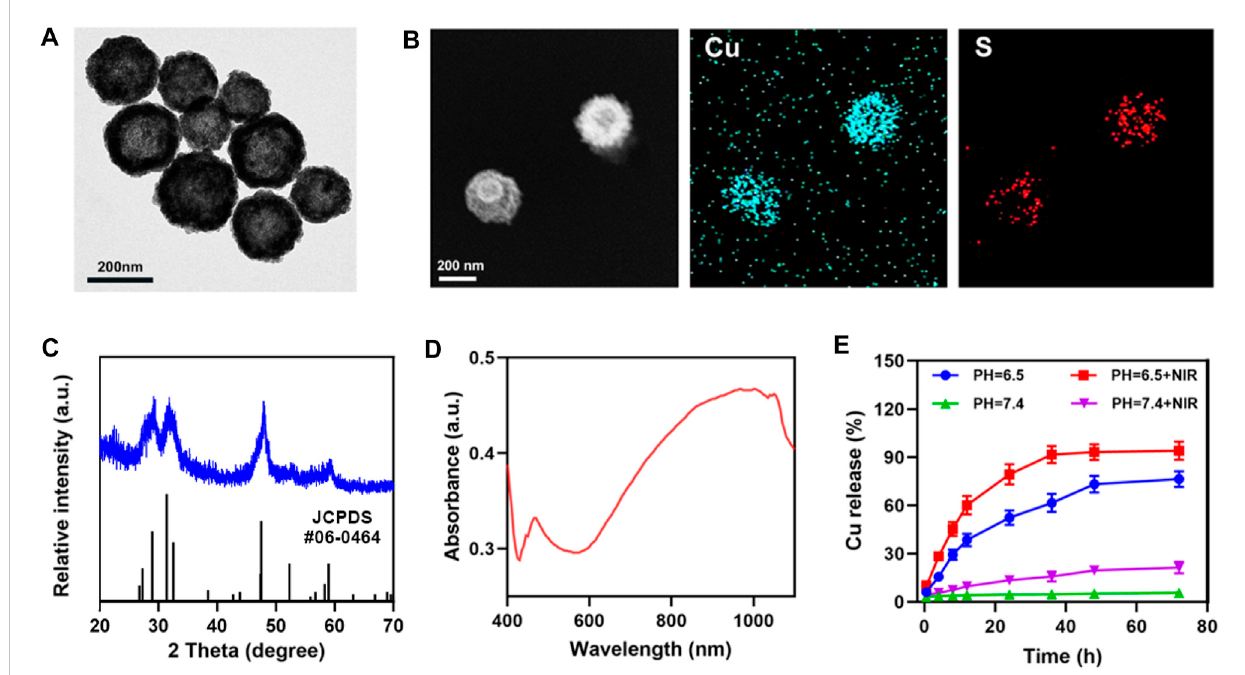
FIGURE 1 (A) TEMimage,and (B) correspondingelementalmappingimagesofCuS. (C) XRDpatternofCuS. (D) CuSabsorbancespectra. (E) Releasepro fi lesof copper ions in weak acidic and neutral environments, with or without irradiation (808 nm, 0.5 W cm − 2